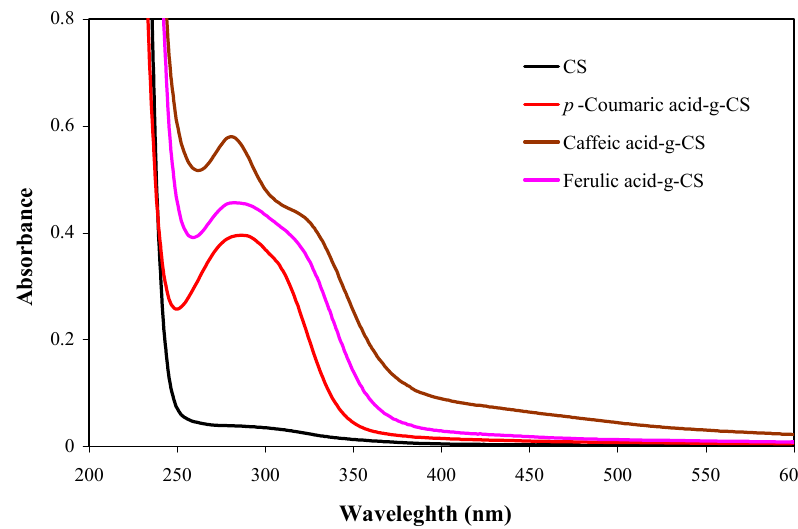
Figure 1. UV-vis spectra of chitosan (CS) and different hydroxycinnamic acid-g-CSs. Hydroxycinnamic acid-g-CSs presented different FT-IR spectra from CS (Figure 2A). The N − H and O − H stretching of CS shifted to 3411–3418 cm − 1 after grafting with